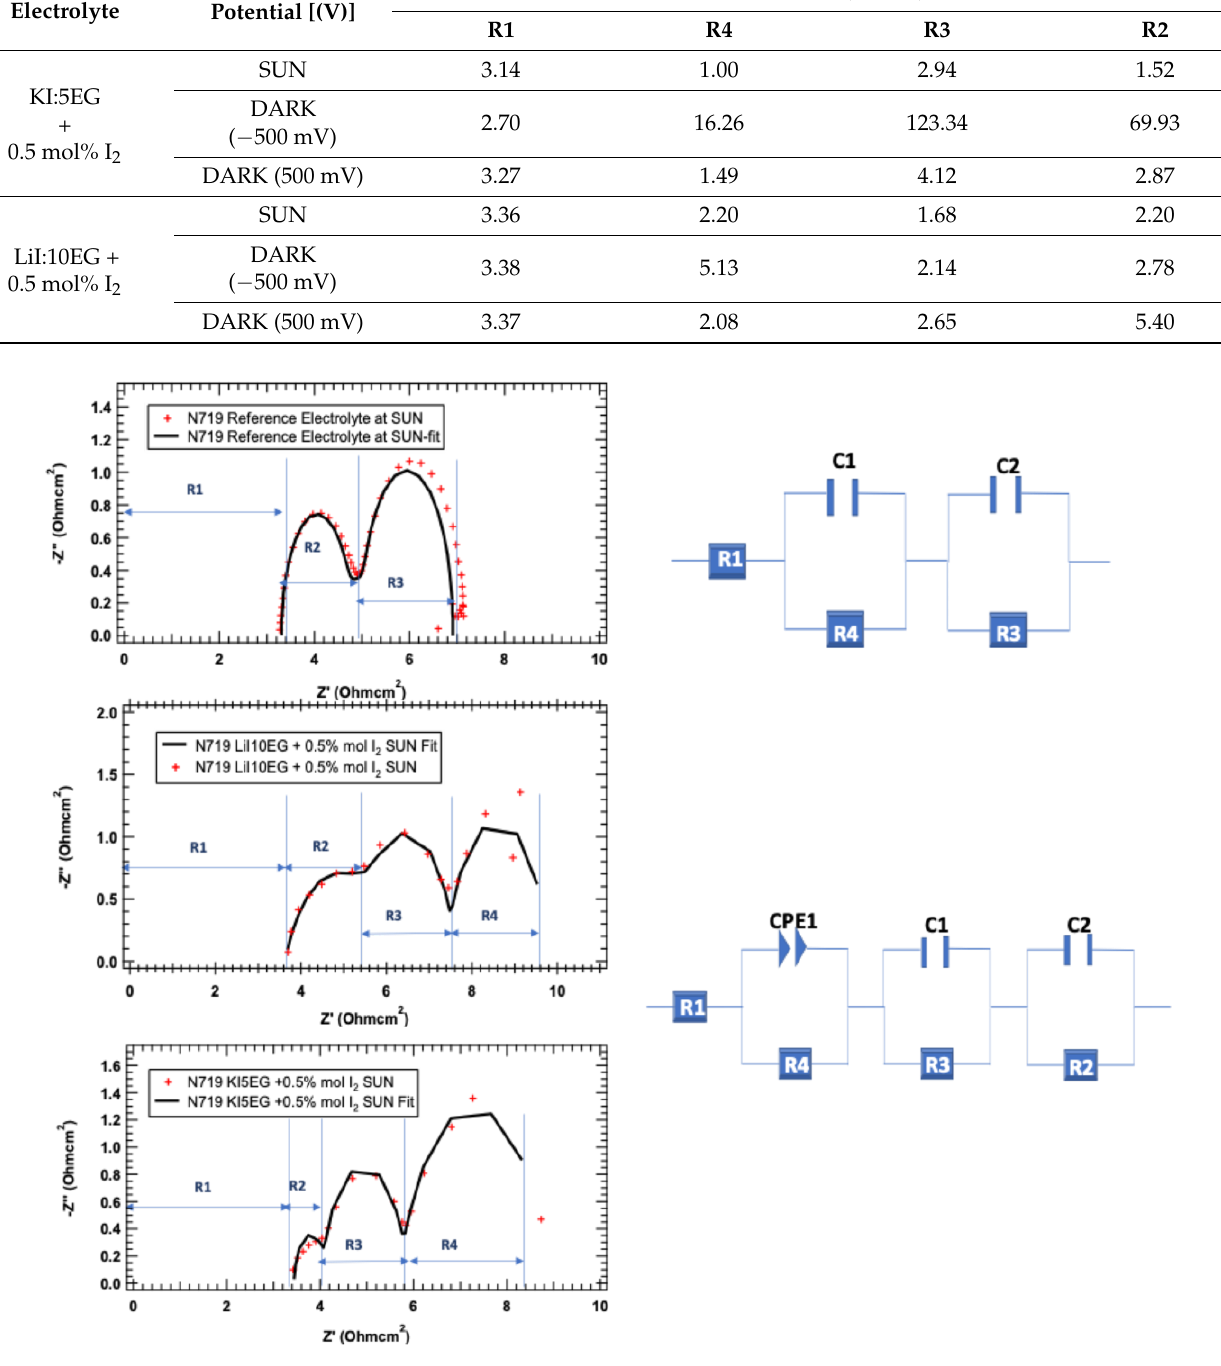
Figure 4. Nyquist plots of Reference ( top ) LiI:10EG + 0.5 mol% I 2 ( middle ) and KI:5EG + 0.5 mol% I 2 ( bottom ) accompanied with the respective fitting and equivalent circuit under illumination.